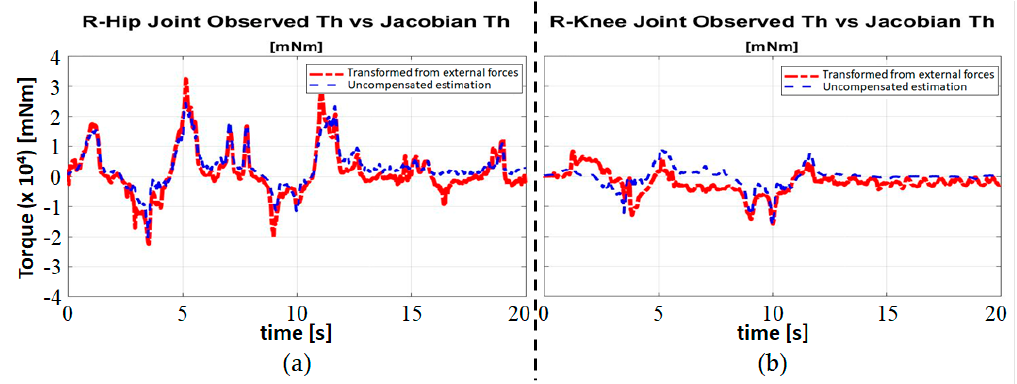
Figure 5. The uncompensated user’s joint torque estimation (red long dashed line) and the equivalent joint torque due to the external force (blue short dashed line): ( a ) right hip; and ( b ) right knee.